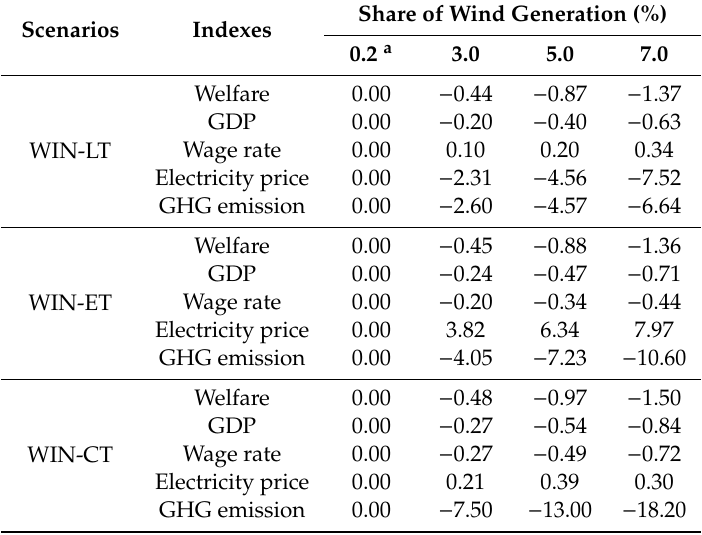
Table 7. Macroeconomic e ff ects of wind generation expansion (% changes from the base year). Share of Wind Generation (%) Scenarios Indexes 0.2 a